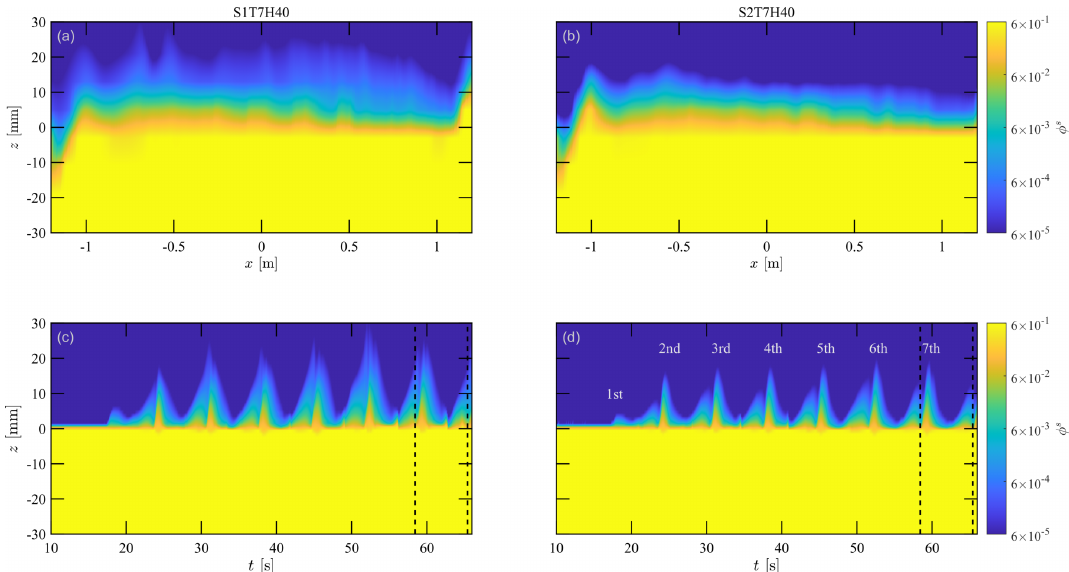
Figure 2. ( a , b ) The x – z plane snapshots of volumetric sediment concentration, φ s ( x , z , t ) , over the sediment pit at t = 59 s and ( c , d ) temporal evolution of φ s ( x , z , t ) at x = 0 for ( a , c ) S1T7H40 and ( b , d ) S2T7H40. Vertical black dashed lines in ( c , d ) represent t / T = 0 and 1 for the seventh wave, respectively. Table 2. A summary of normalized root-mean-square-errors for selected variables in model